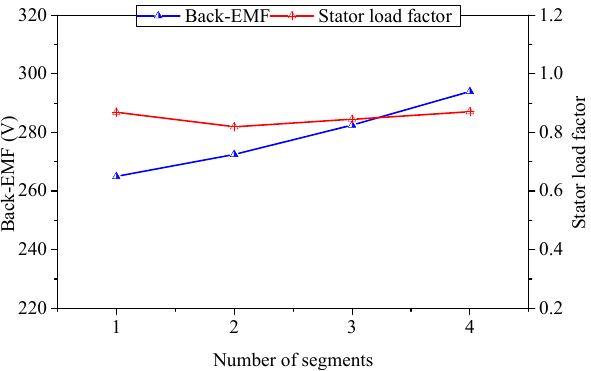
Figure 9. Back-EMF and stator load factor with different spoke-type structures.